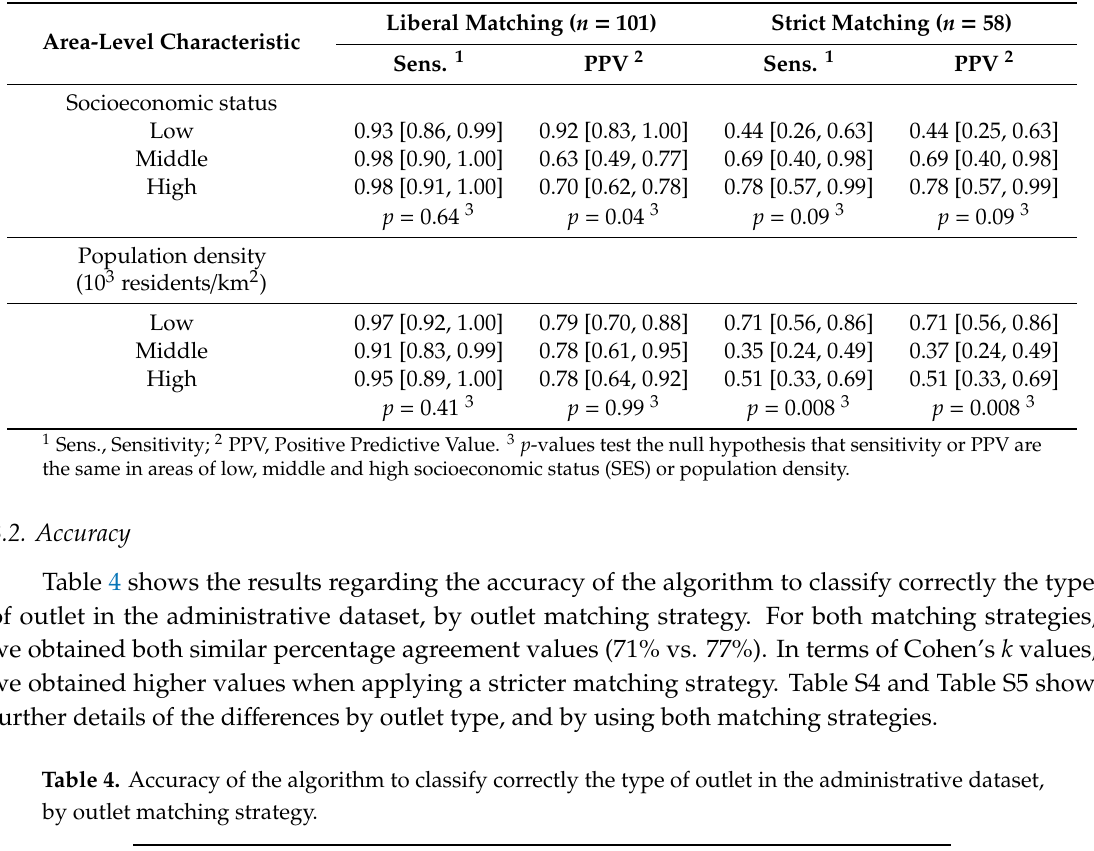
Table 3. Assessment of the systematic bias of the administrative data according to area-level socioeconomic status and population density.